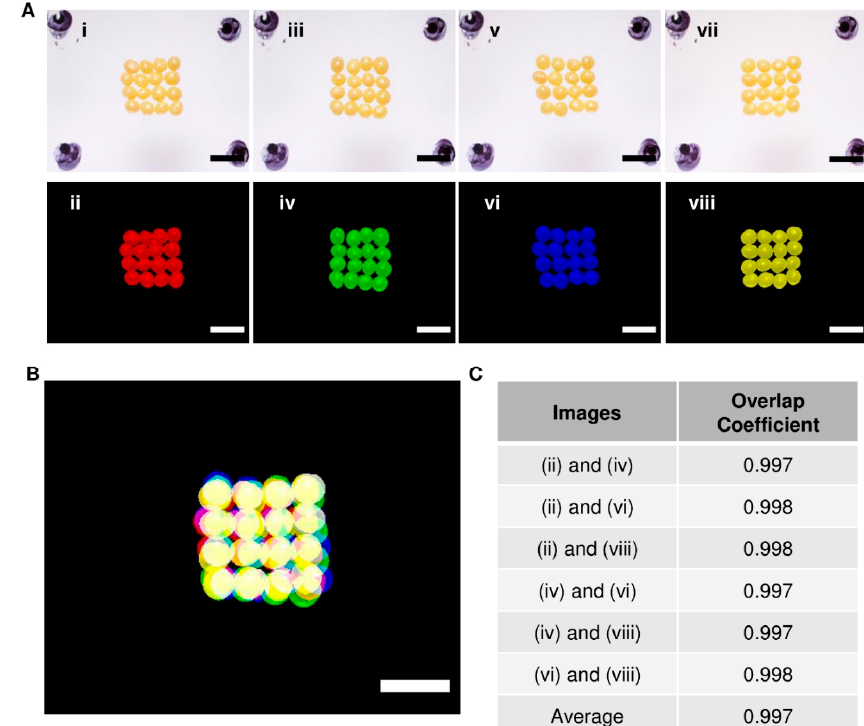
Figure 4. Bead layer-by-layer overlap coefficient determination. To determine the precision of the bioprinter, ( A ) layers of beads were added to a predefined area (upper panels), and each run was assigned a color (lower panels). ( B ) Images from individual runs were overlapped using ImageJ. The yellow color indicates the overlap of the beads. ( C ) The overlap coefficient was determined (Colocalization Finder for ImageJ) using the images, and the average overlap coefficient was found to be 0.997. Scale bars: 2 mm.